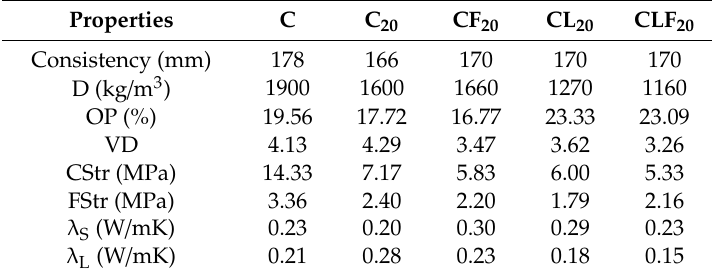
Table2. Physical, mechasnical and thermal properties of the PCM cement-lime mortars (adapted from [16]).